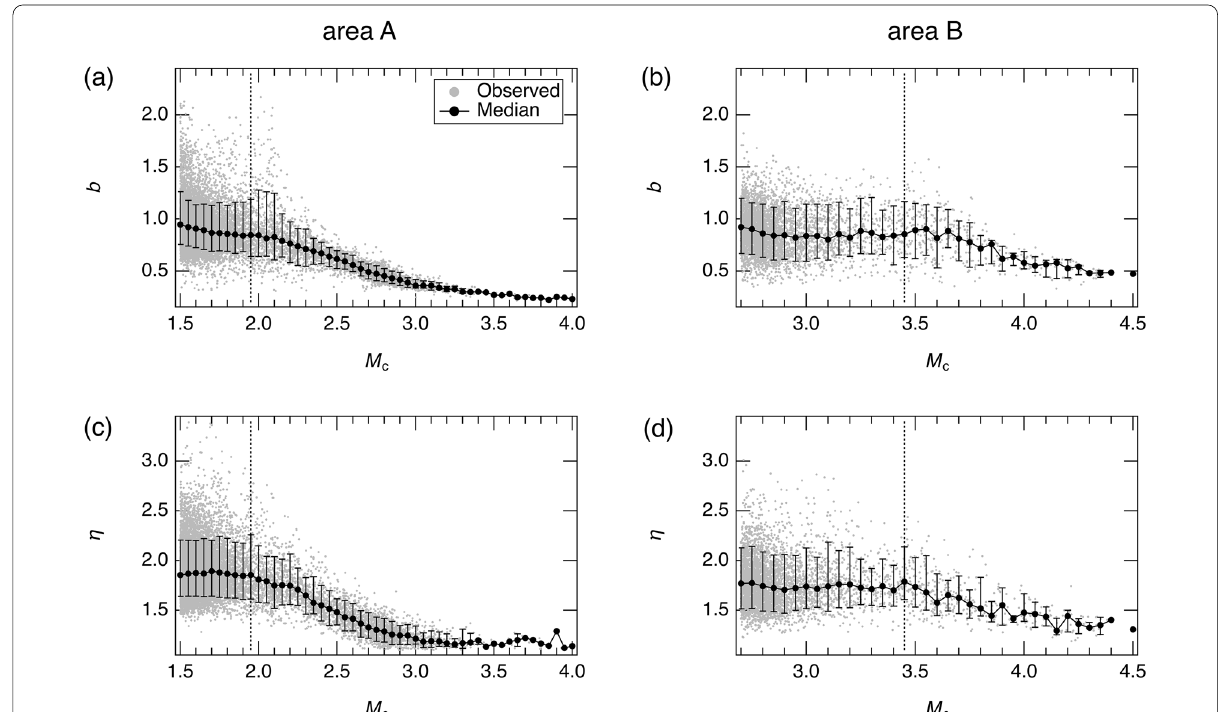
0.4 ◦ and N 50 . a , c Area A; b , d area B. The median of each index value entering a bin of = =